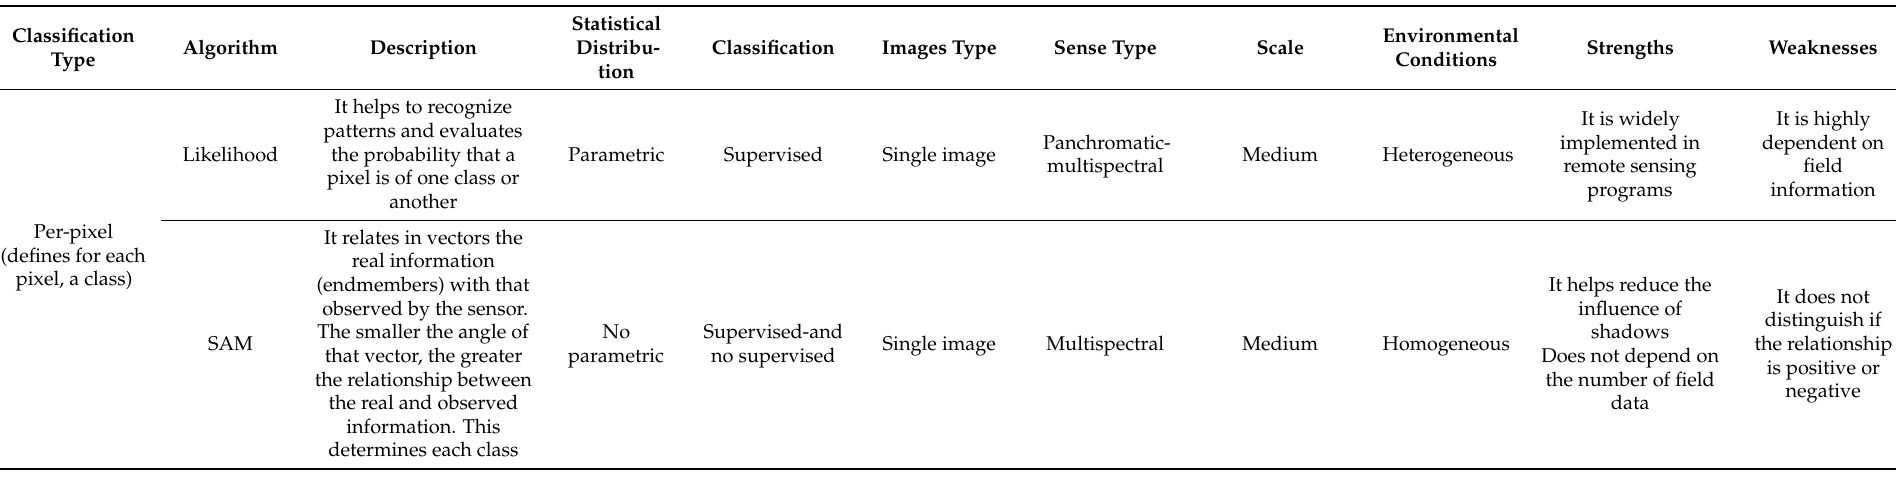
Table 1. General characteristics of likelihood and SAM